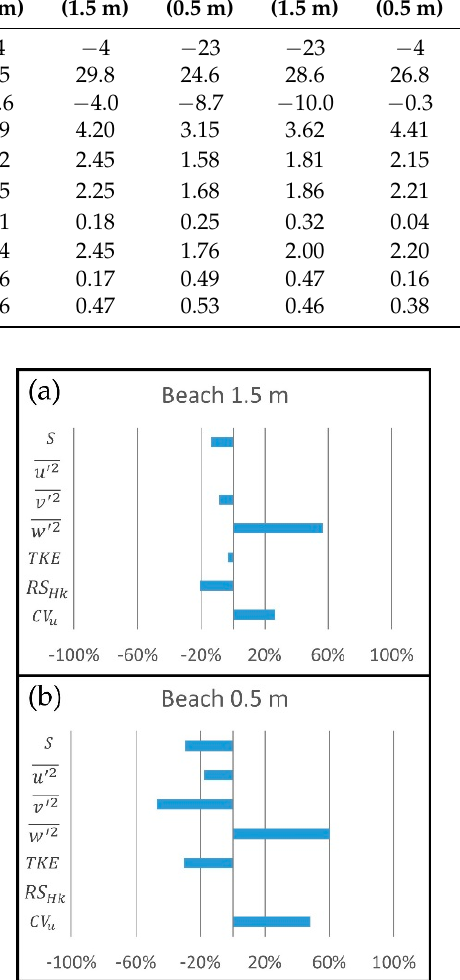
Figure 11. Percent difference in normalized flow quantities over the beach (calculated as: (T1 − T2)/T2B 1.5 ) between similar anemometer locations on T1 (LWD) and T2 (no LWD) over all runs and flow quantities: resultant 3D wind speed ( S , m s − 1 ), normal kinematic Reynolds stresses ( (cid:1873) (cid:4593)(cid:2870) (cid:3364)(cid:3364)(cid:3364)(cid:3364),(cid:1874) (cid:4593)(cid:2870) (cid:3364)(cid:3364)(cid:3364)(cid:3364),(cid:1875) (cid:4593)(cid:2870) (cid:3364)(cid:3364)(cid:3364)(cid:3364)(cid:3364) , m 2 s − 2 ), turbulent kinetic energy ( TKE , m 2 s − 2 ), horizontal kinematic Reynolds stress ( (cid:1844)(cid:1845) (cid:3009)(cid:3038) , m 2 s − 2 ), and the coefficient of variation ( CV (cid:2931) ). ( a ) Beach 1.5 m; ( b ) Beach 0.5 m. LWD fronting the foredune had a clear and measurable effect on flow over the upper beach and was highly effective at altering flow characteristics measured at both 1.5 and 0.5 m (Figure 11). Overall, there were consistent decreases in mean wind speed (S), spanwise normal stress ( (cid:1874) (cid:4593)(cid:2870) (cid:3364)(cid:3364)(cid:3364)(cid:3364) ), turbulent kinetic energy (TKE) at T1 (with LWD) relative to T2 (without LWD). Similarly, there was a consistent increase in turbulence intensity ( CV (cid:2931) ) at T1. These differences in flow dynamics in the presence of LWD indicate that the enhanced roughness exerts additional drag on the flow field, extracting energy from the mean flow (i.e., decrease in S and TKE) and converting it to enhanced turbulent motion (i.e., increase in CV (cid:2931) ). Also noteworthy is the near 60% increase in (cid:1875) (cid:4593)(cid:2870) (cid:3364)(cid:3364)(cid:3364)(cid:3364)(cid:3364) on the beach resulting from flow deflection up and over the LWD, despite the small magnitude of the vertical motions relative to the horizontal components. The 50% reduction in (cid:1874) (cid:4593)(cid:2870) (cid:3364)(cid:3364)(cid:3364)(cid:3364) at T1B 0.5 can be attributed to two primary factors. First, the LWD-induced drag close to the sand surface reduces overall mean and fluctuating energy because the wind slows down within the LWD matrix (Table 2). Second, spanwise fluctuations are subdued because the individual logs act as physical barriers to lateral flow, and therefore the wind is directed up and over the LWD. In this way, spanwise fluctuating energy is transformed into vertical fluctuating energy. The strong increase in (cid:1875) (cid:4593)(cid:2870) (cid:3364)(cid:3364)(cid:3364)(cid:3364)(cid:3364) at T1B 0.5 (Figure 12, bottom) supports this assertion.